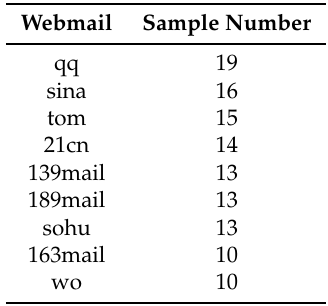
Table 7. Malicious Sample Number for Webmail.